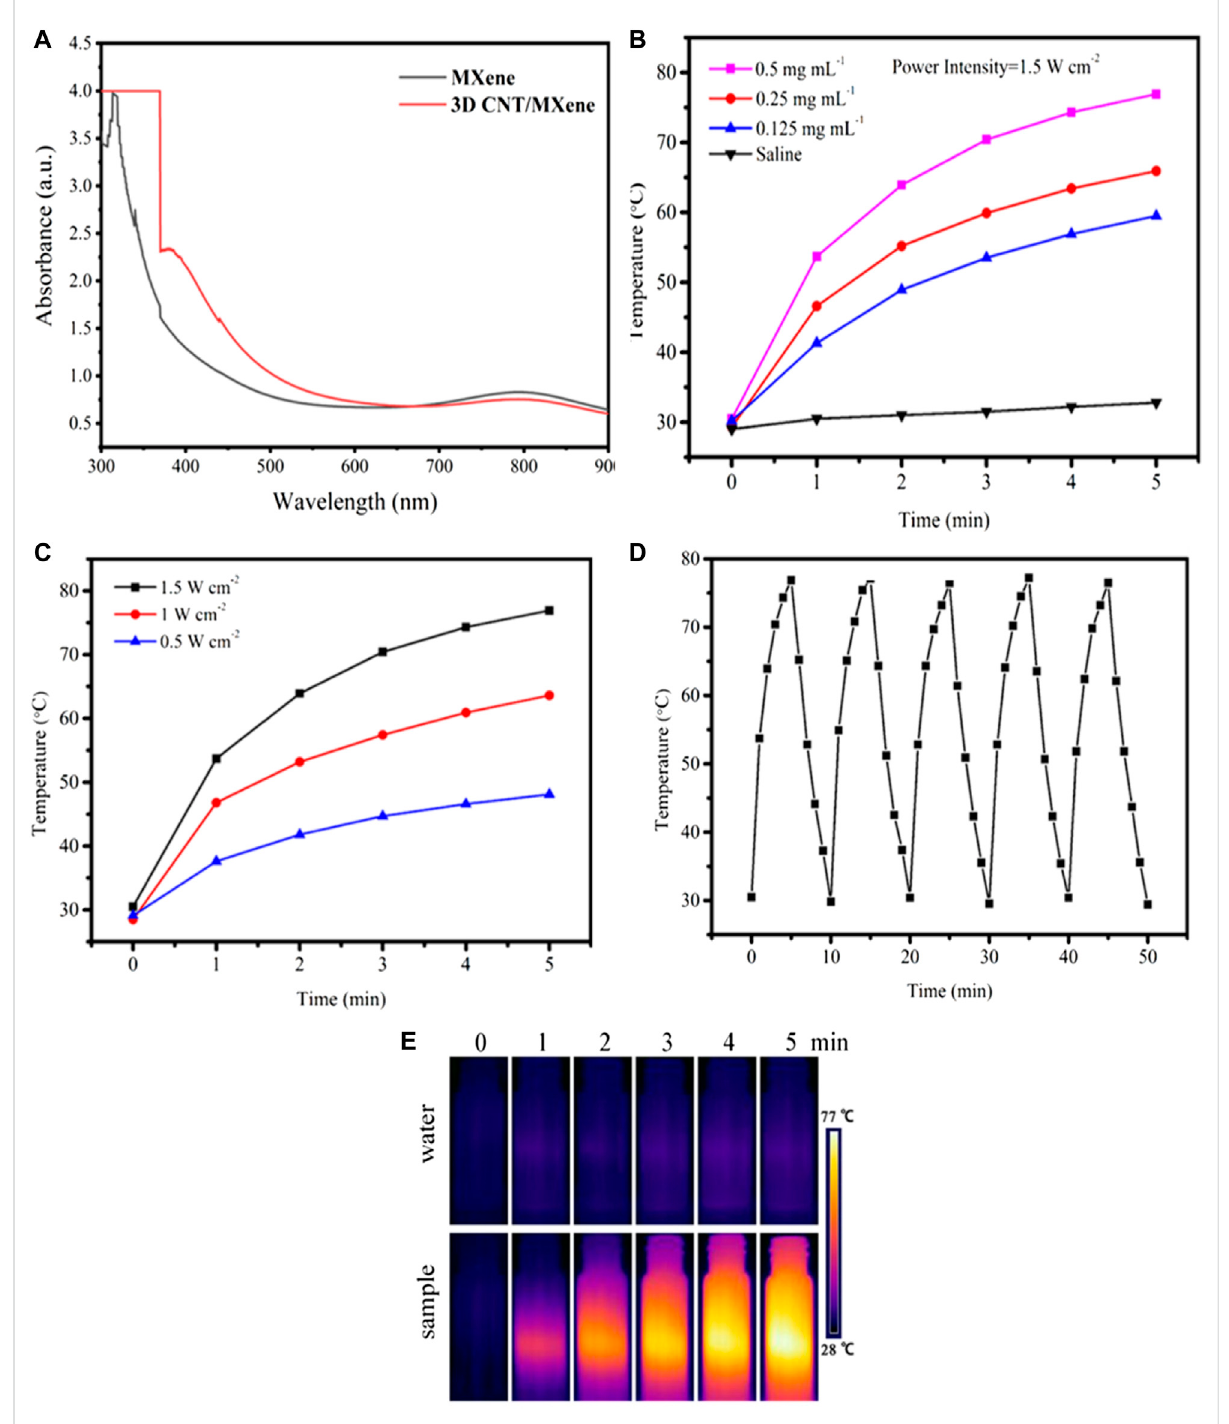
FIGURE 5 (A) UV-vis absorption spectra of MXene and 3D CNT/MXene, respectively. (B) Photothermal pro fi le of 3D CNT/MXene solution at different concentrations (808 nm, 1.5 W cm − 2 ). (C) Photothermal pro fi le of 3D CNT/MXene solution (500 μ g mL − 1 ) under different laser power densities.